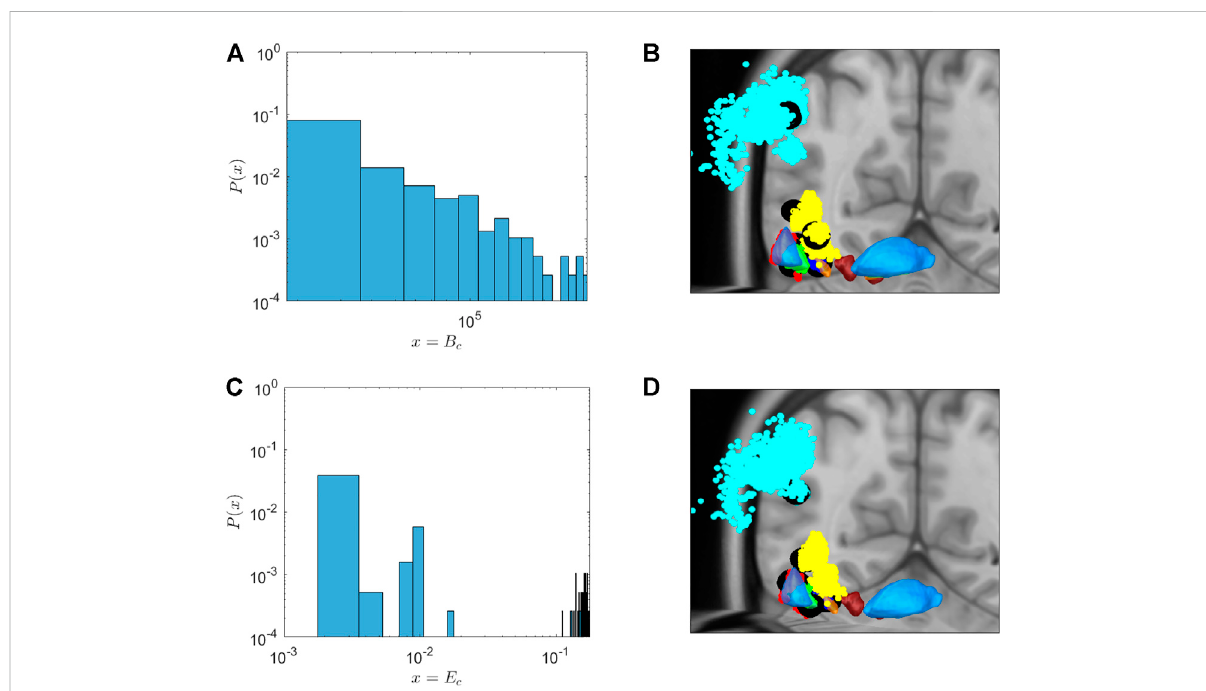
FIGURE 3 Probability distribution (A,C) andposition (B,D) ofnodeswithhighcentrality measures. (A,C) :Probability distributionofcentrality nodes. (A) The distribution of “ betweenness centrality ” follows a power law distribution. Thus, > 90% of the nodes have a “ betweenness centrality ” < 20,000, and only0.5%acentralityvalueof200,000. (C) Thedistributionof “ eigencentrality ” alsofollowsapowerlawdistribution.Thus,again > 99%ofthenodes have a value < 0.2, and only 0.2% an “ eigencentrality ” value of 0.17. (B,D) Position of high centrality nodes (i.e., the nodes with the highest B c or E c values in each region, usually with a B c > 200.000/ E c > 0.17) in MNI brain space coordinates shown as black dots. Brain regions are colour-coded as given in the fi gure. Most of these nodes are located in STN and GPi, thalamus (Tha) and GPe, but also some in the motor cortex